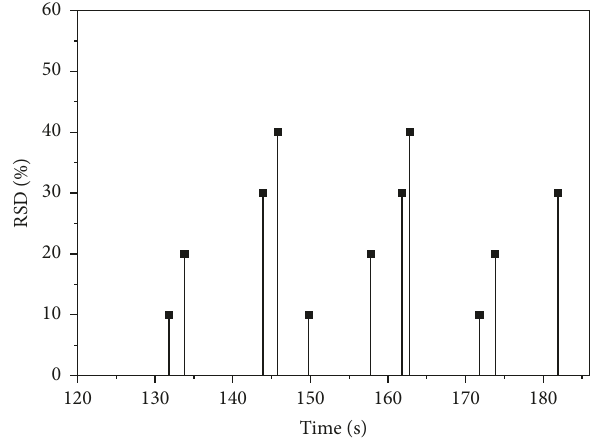
Figure 3: α amino acid neutral loss scan mass